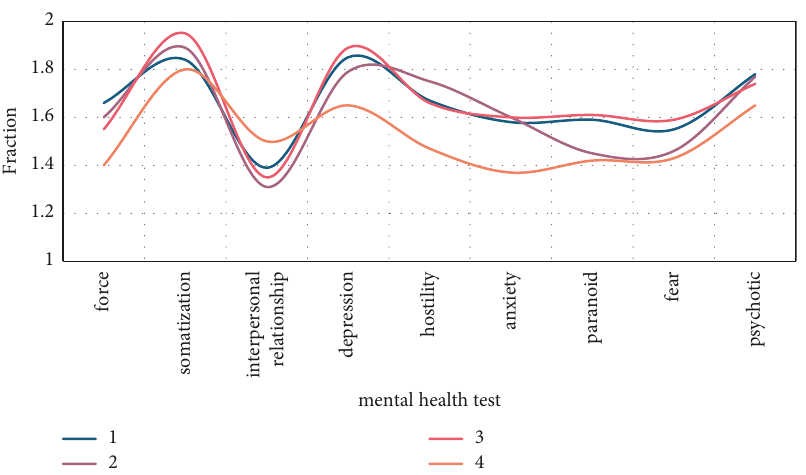
Figure 8: Comprehensive comparison of mental health levels.